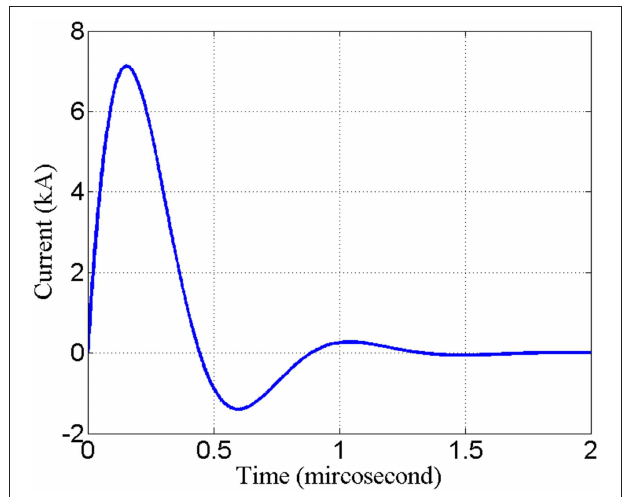
FIGURE 4 | Schematic diagram of the waveform of current passing through an 8-shaped coil.